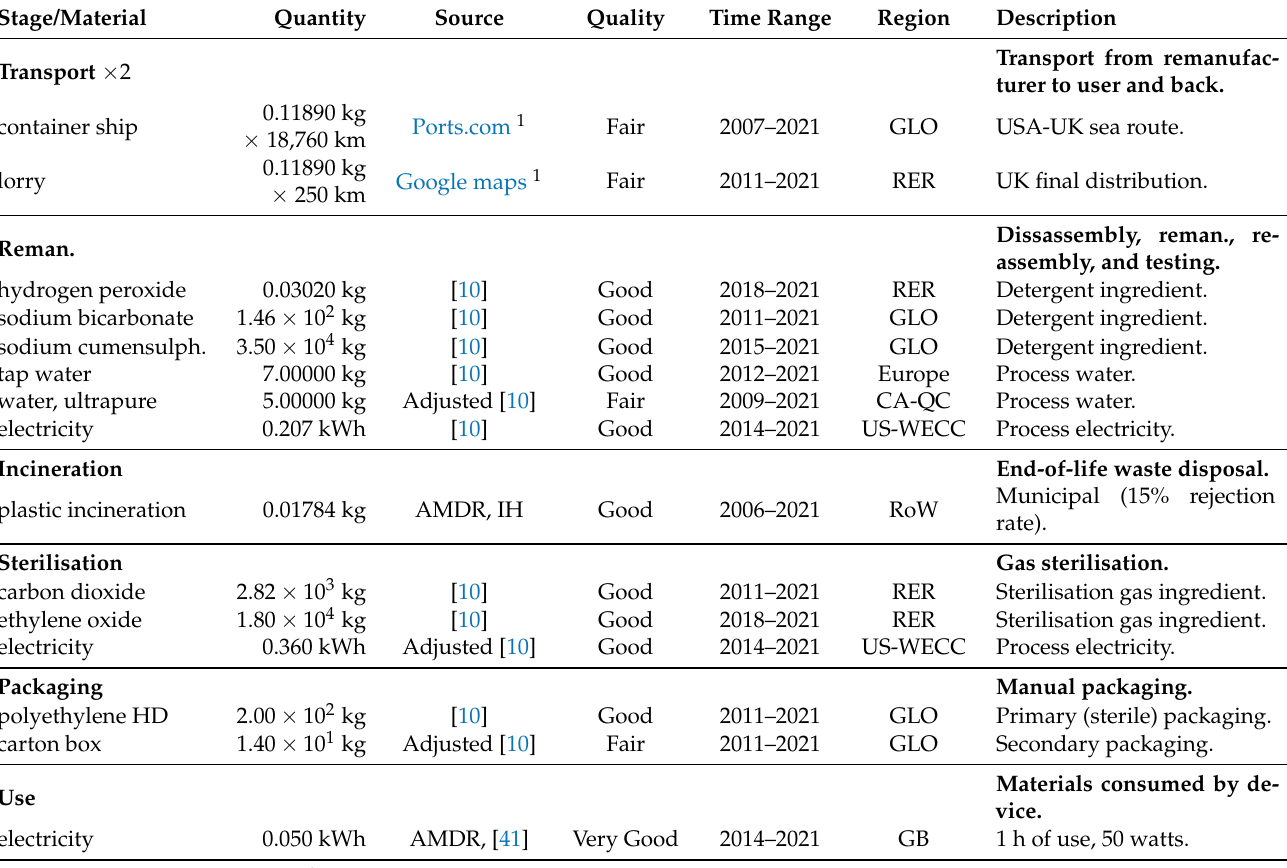
Figure 3. Remanufactured catheter product system. The life stages are arranged in a circular life cycle from cradle-to-grave, which here is defined as from the transportation of a used catheter to its re- use after successful remanufacturing. We follow the cut-off system that is marked by the square system boundary. Table 4. Remanufacturing life stages and materials . The materials are based on [10] and supplemented with primary data from our collaborators, medical device remanufacturers AMDR and Innovative Health. The data quality was assessed with the rubric in Table 2 and region marks the Ecoinvent production